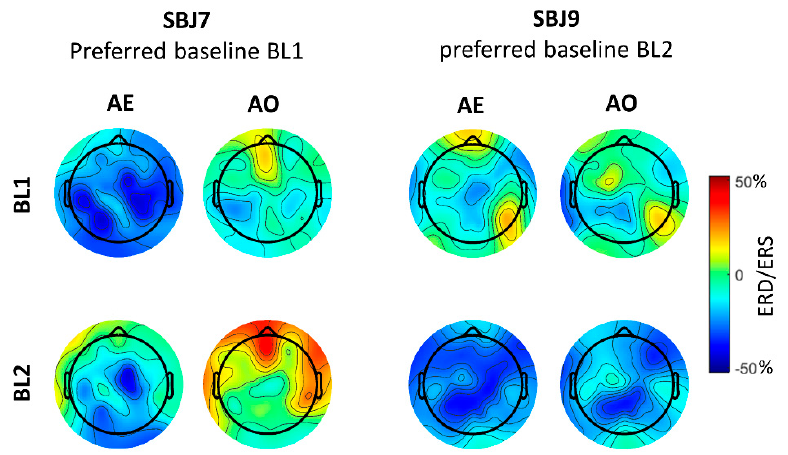
Figure 5. Topographic maps of mu-rhythm ERD/ERS [%] for SBJ7 and SBJ9, which show a preference for BL1 and BL2, respectively.